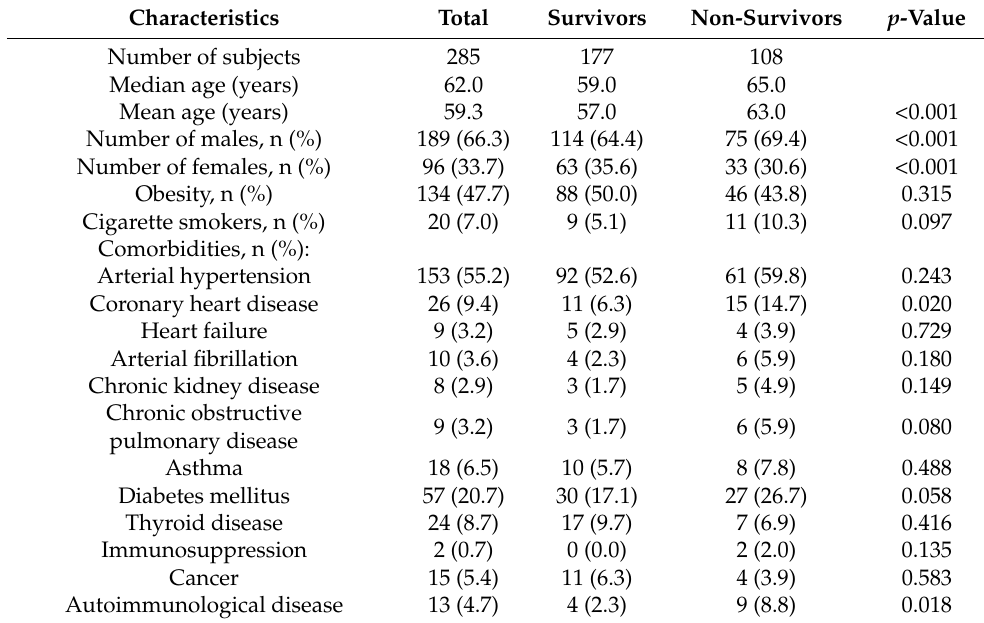
Table 1. The demographic and clinical